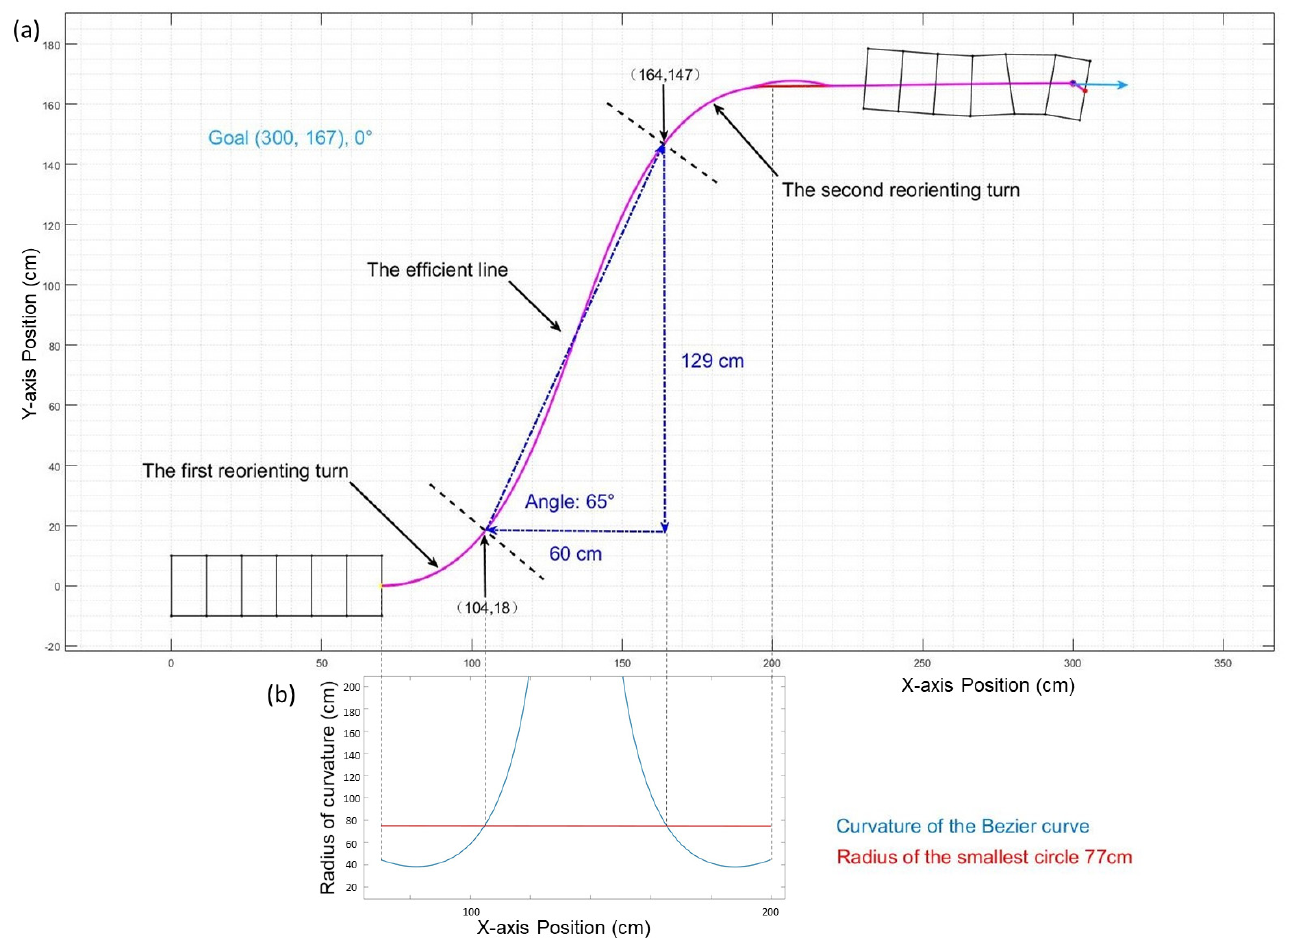
Figure 4. ( a ) The whole path (pink line) is separated into three parts. The first reorienting turn is from the beginning to (104, 18), the efficient line is from (104, 18) to (164, 147) (dashed line), and the second reorienting turn is from (164, 147) to the goal point (300, 167). ( b )The path curve’s corresponding curvature radius with respect to x position.